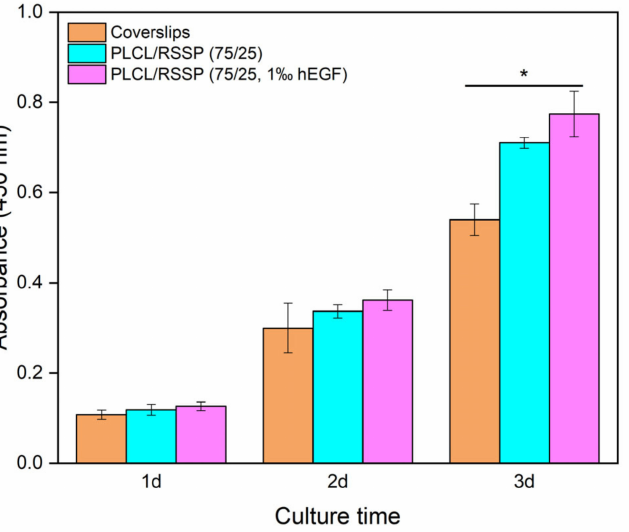
Figure 7. The proliferation of NIH-3T3 cells on the cover slips, PLCL/RSSP (75/25) and PLCL/RSSP (75/25, 1‰ hEGF) membranes. (* p <